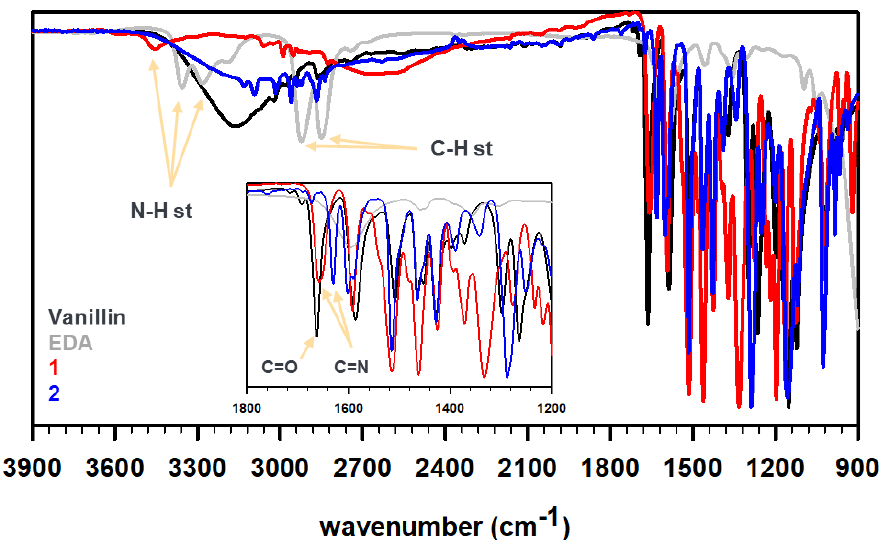
Figure 1. FT-IR profiles of vanillin (black), ethylene diamine (gray), and as-synthesized Schiff bases 1 (red) and 2 (blue).